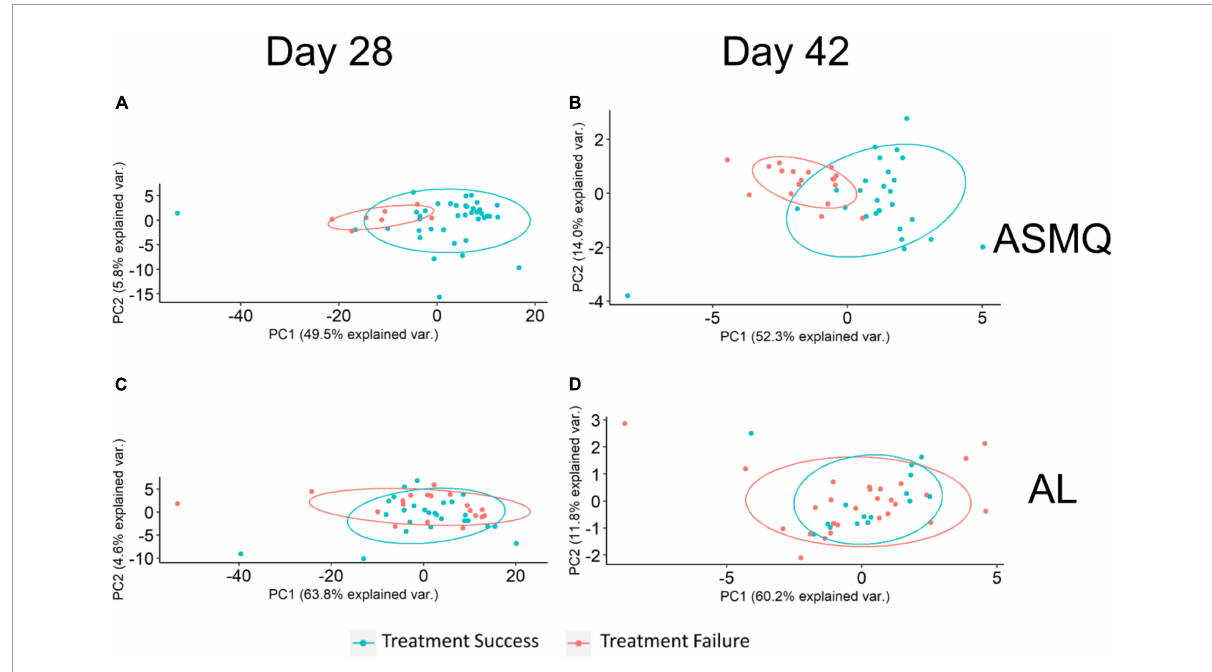
FIGURE3 Principal Component Analysis (PCA) plots of treatment outcome-specific differences. (A,B) . PCA used antibody signals with adjusted P < 0.1 to visualize treatment outcome-specific differences in the ASMQ arm, which were identified by univariate analyses applied to identify differences in subjects’ humoral immunity associated with ASMQ outcomes on day 28 and 42, respectively. (C,D) . PCA used the same antibody signals as (A,B) to visualize treatment outcome-specific differences in the AL arm.